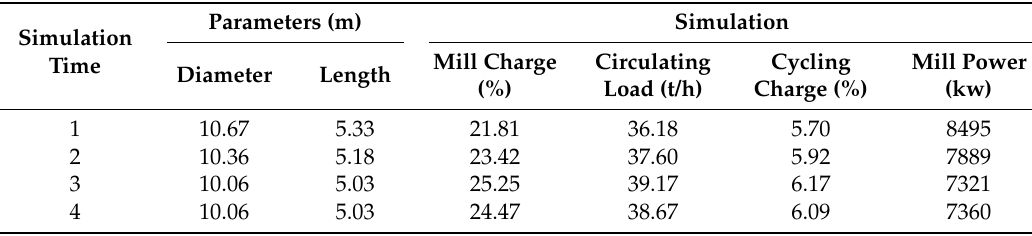
Table 5. Simulation progress for SAG mill